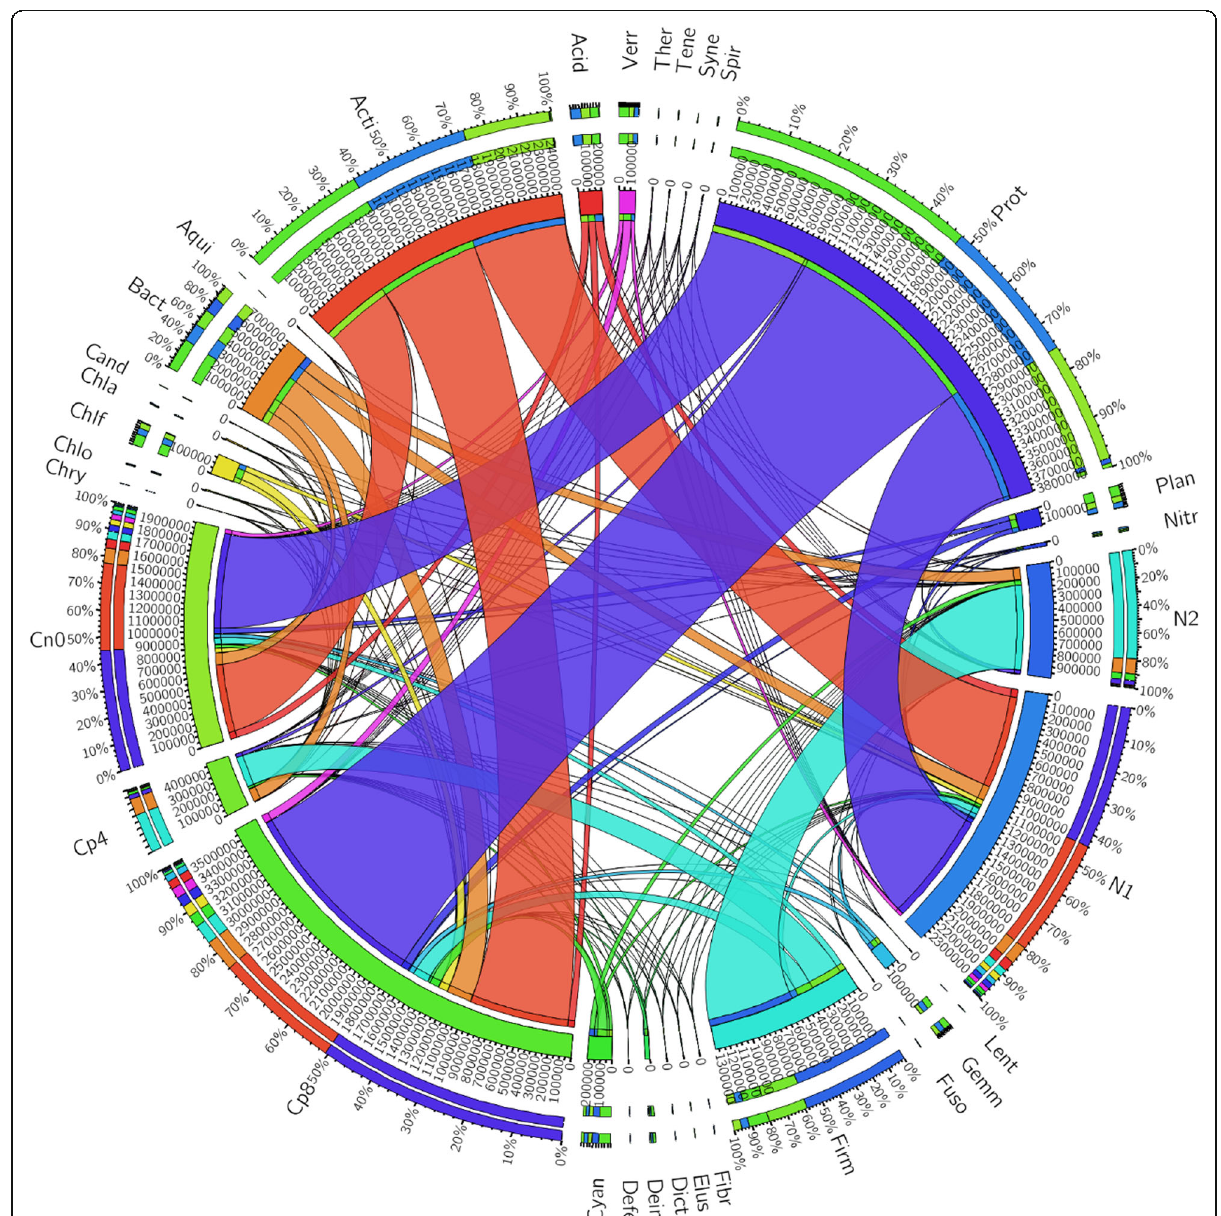
Fig. 6 The abundance of bacterial phyla across the treatments from the maize rhizosphere soil samples, Cn0 (control), N1 (60 kg/ha NPK), N2 (120 kg/ha NPK), Cp8 (8 tons/ha compost), and Cp4 (4 tons/ha compost manure). The bacteria abbreviations are presented as follows: Acid ( Acidobacteria ), Acti ( Actinobacteria ), Aqui ( Aquificae ), Bact ( Bacteroidetes ), Cand ( Candidatus Poribacteria ), Chla ( Chlamydiae ), Chlo ( Chlorobi ), Chlf ( Chloroflexi ), Chry ( Chrysiogenetes ), Cyan ( Cyanobacteria ), Defe ( Deferribacteres ), Dein ( Deinococcus - Thermus ), Dict ( Dictyoglomi ), Elus ( Elusimicrobia ), Fibr ( Fibrobacteres ), Firm ( Firmicutes ), Fuso ( Fusobacteria ), Gemm ( Gemmatimonadetes ), Lent ( Lentisphaerae ), Nitr ( Nitrospirae ), Plan ( Planctomycetes ), Prot ( Proteobacteria ), Spir ( Spirochaetes ), Syne ( Synergistetes ), Tene ( Tenericutes ), Ther ( Thermotogae ), Verr ( Verrucomicrobia